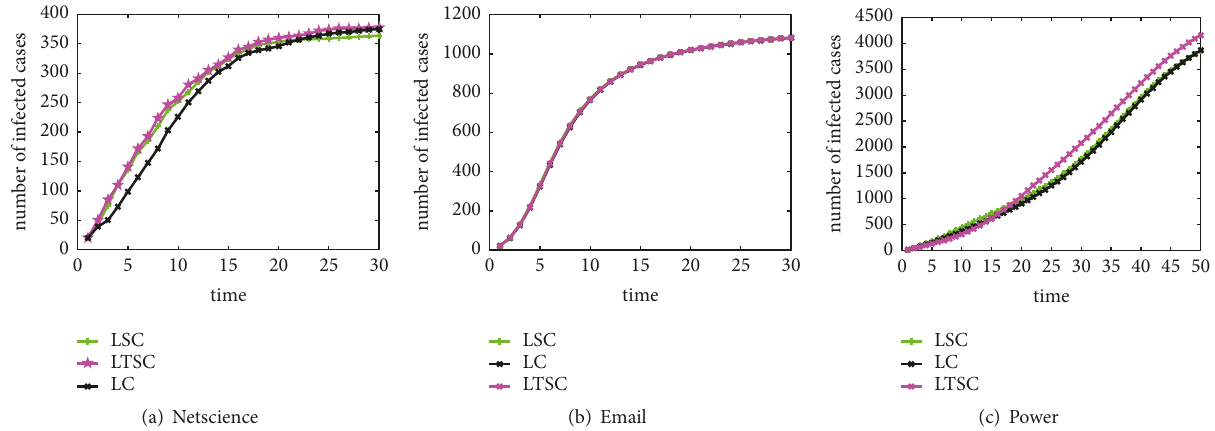
Figure 6: Comparing the number of infected nodes by LC, LSC, and LTSC in the SI model, respectively, where the infection probability is the epidemic threshold 𝛽 𝑡ℎ